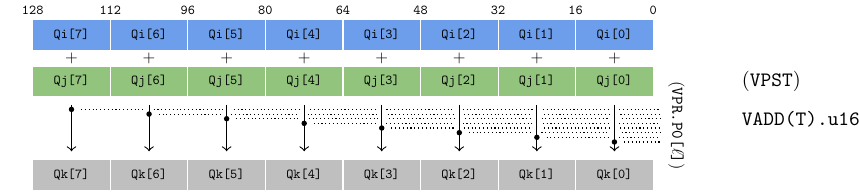
Figure 1 Parallel 16-bit addition using VADD.u16 , with/without